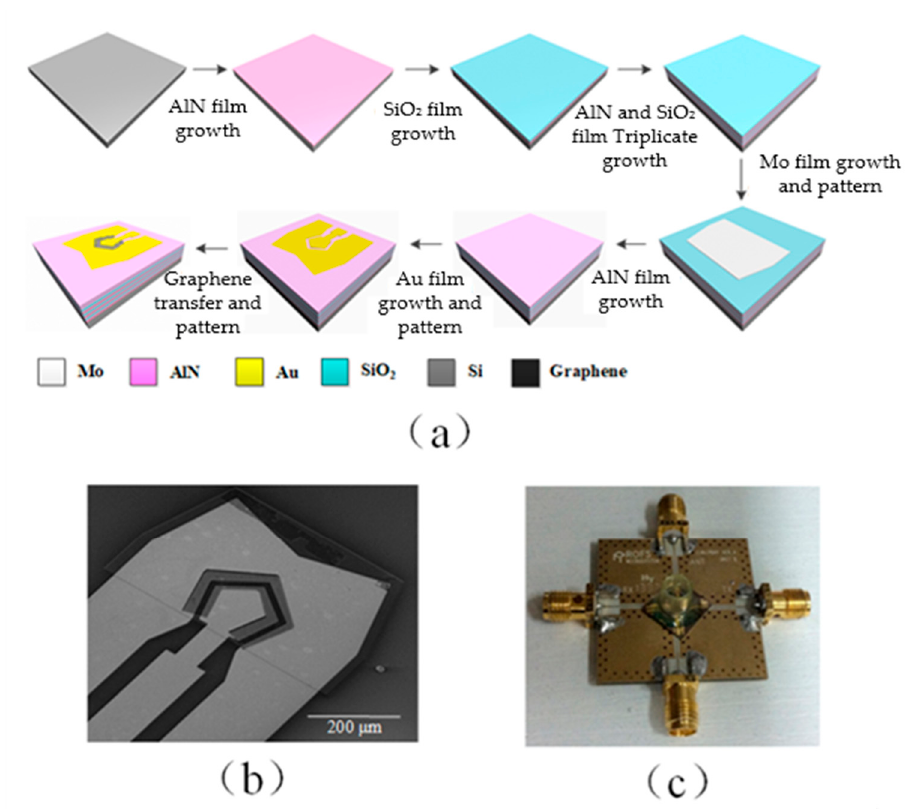
Figure 2. ( a ) The entire process flow SMR fabrication and graphene transfer. ( b ) SEM image of the device. The scale bar is 200 µ m. ( c ) Image of a completed device mounted on the evaluation board.